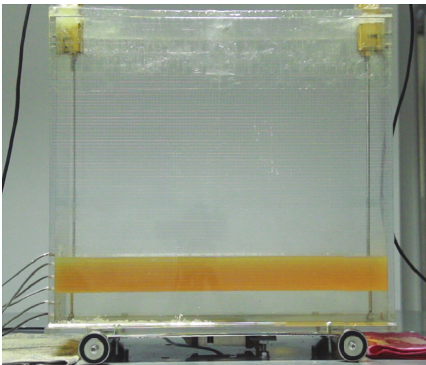
Figure 1: Schematic diagram of oil-water stratified liquids sloshing test device.